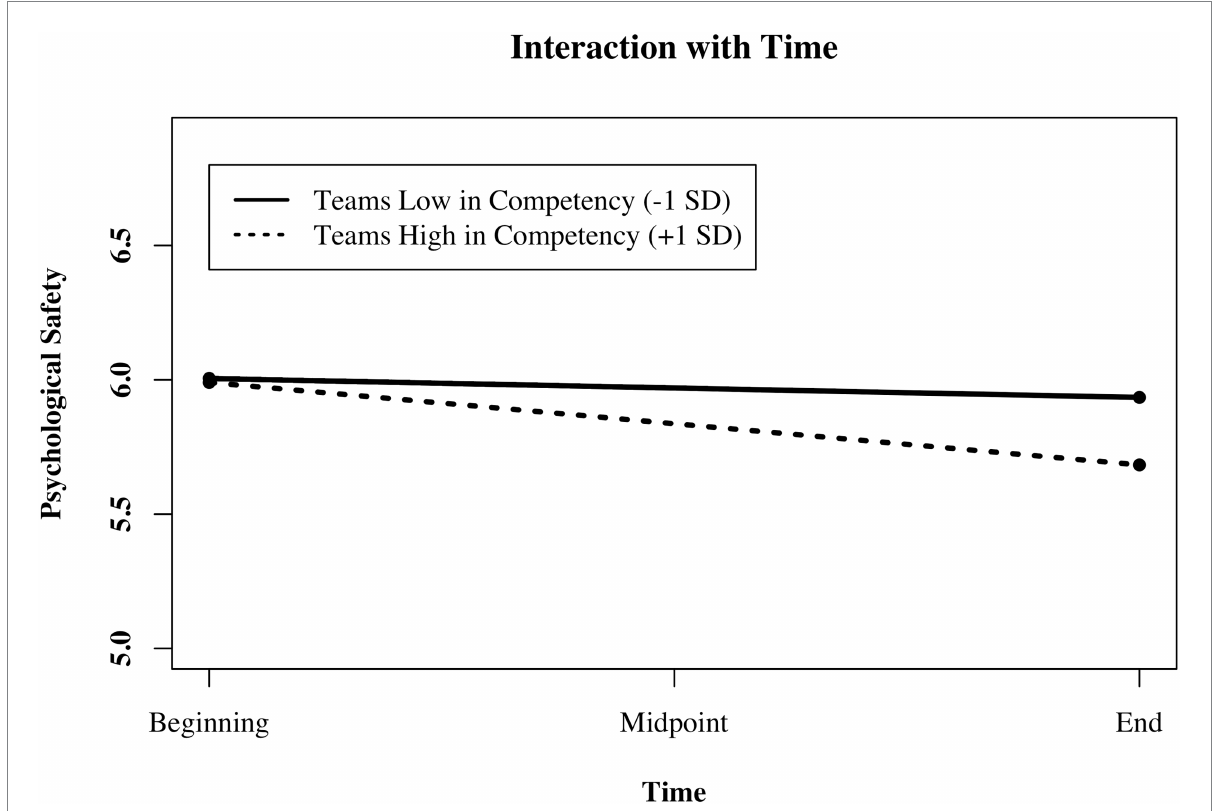
FIGURE 2 Illustration of the interaction between mean group member competency (low vs. high) and time predicting changes in psychological safety in research teams ( N = 699 measurement points in time, nested in 233 members in 61